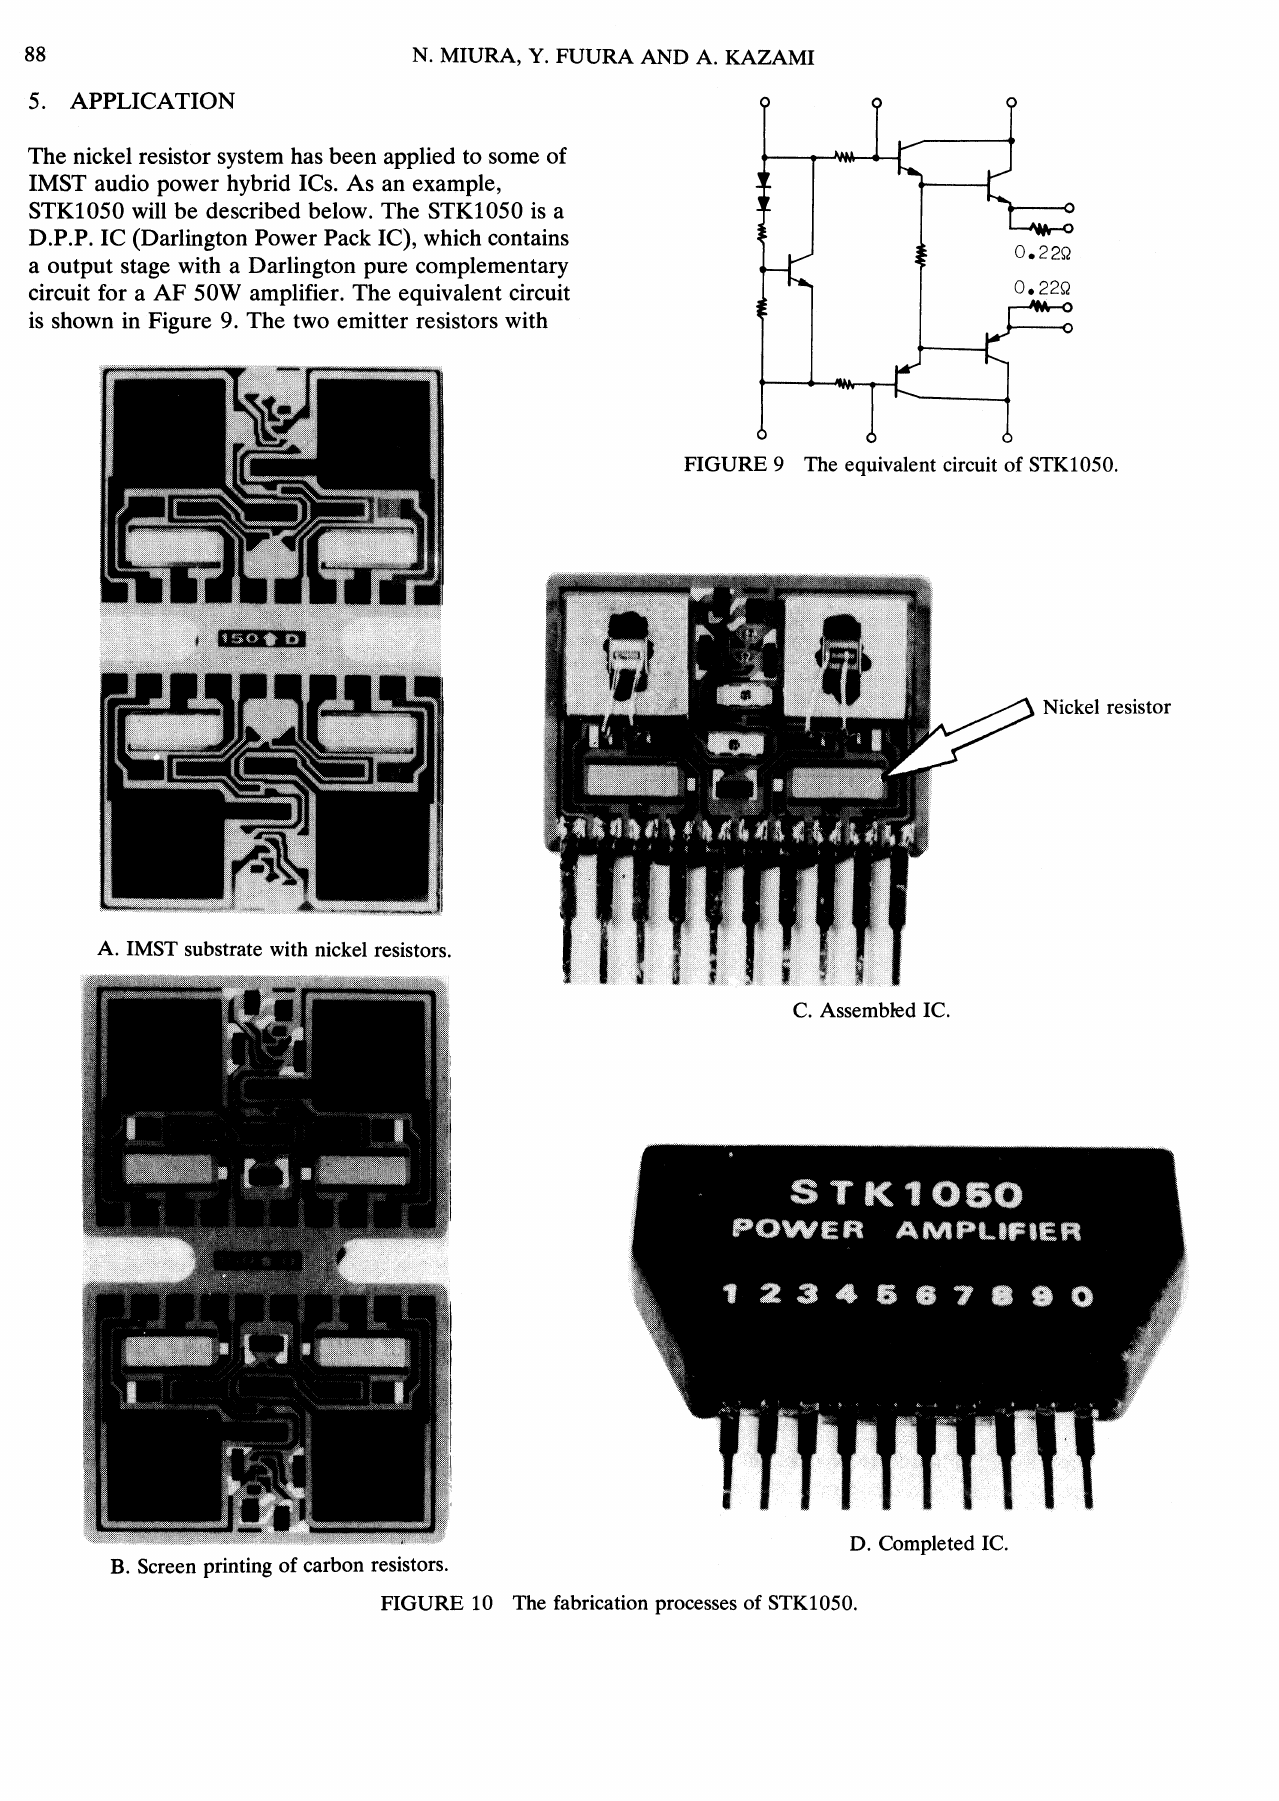
FIGURE 10 The fabrication processes of